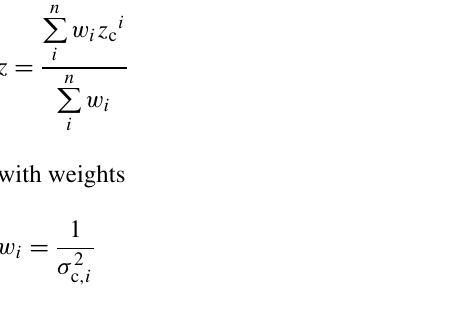
uncertainty is multivariate, it is also nontrivial to